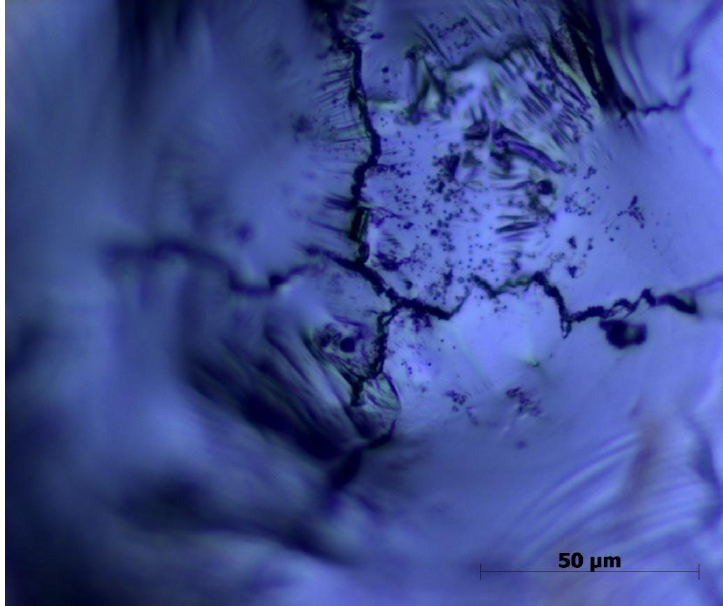
Figure 10. The crack visible under confocal microscopy.